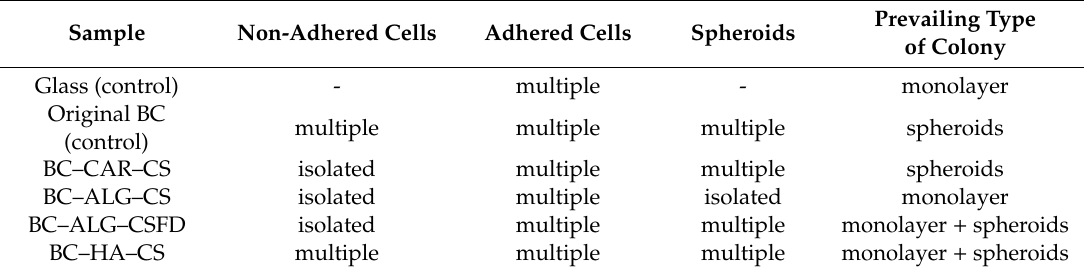
Table 5. Characteristics of multipotent mesenchymal stem cells and cell colonies formed on the surface of the scaffolds.